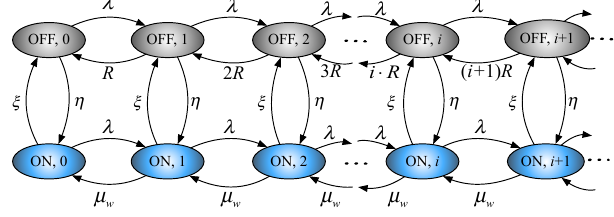
Figure 6: The 2D Markov chain for the WiFi